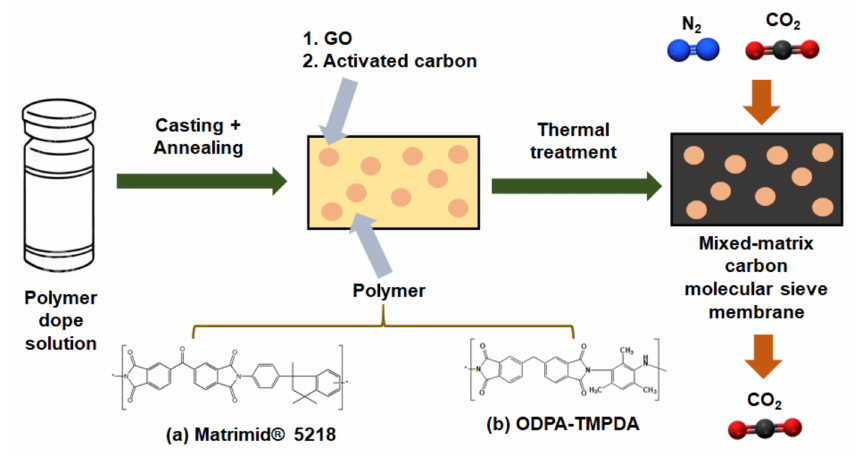
Figure 2. Synthesis scheme for the development of mixed-matrix carbon molecular sieve membranes containing ( 1 ) graphene oxide (GO) and ( 2 ) activated carbon derived from: ( a ) Matrimid ® 5218 and ( b ) ODPA-TMPDA